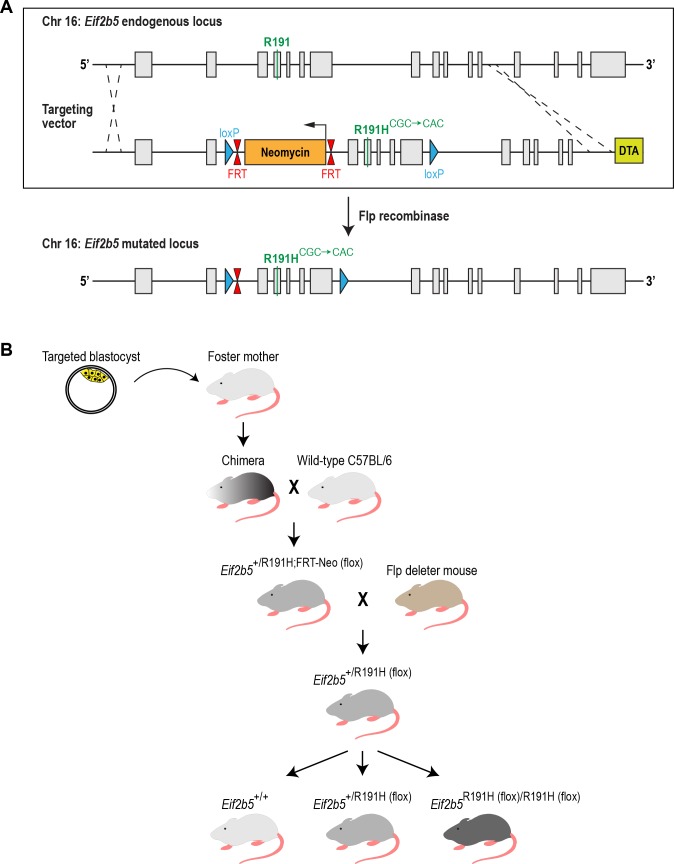
Generation of the R191H (Eif2b5R191H (flox)/R191H (flox)) mouse model.(A) Schematic of the mouse Eif2b5 locus and the targeting vector used. Gray bars, exons; black lines, introns; DTA, diphtheria toxin negative selection cassette. A single base point mutation (CGC to CAC) in exon four changed Arg191 to His. Excision of the neomycin selection cassette by Flp recombinase left behind a single FRT site and two loxP sites flanking exons 3–7. (B) Breeding scheme used to generate homozygous R191H mice. Experiments were performed with homozygous mice from heterozygous parents, and their WT littermates as controls.